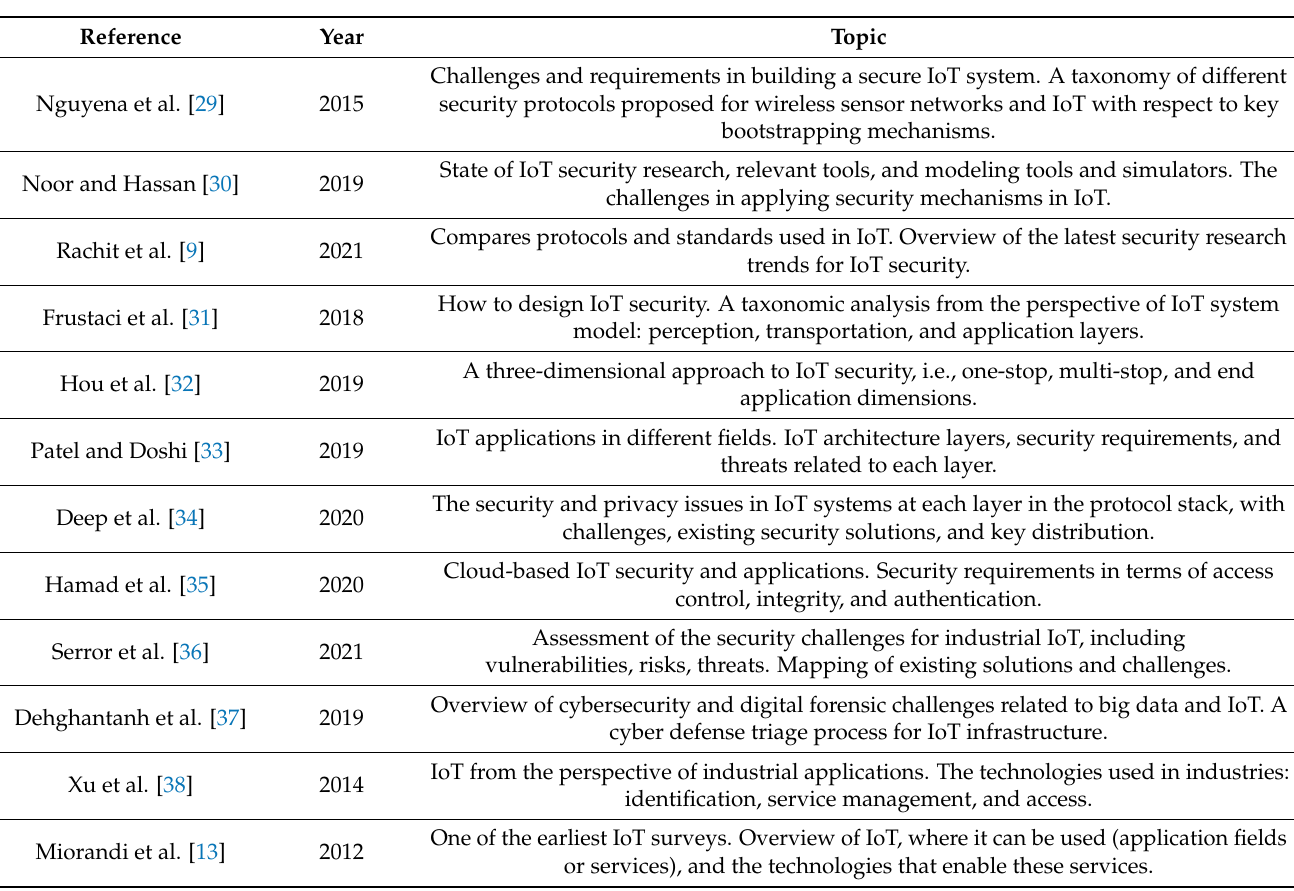
Table 3. Papers about challenges and requirements in implementing IoT.